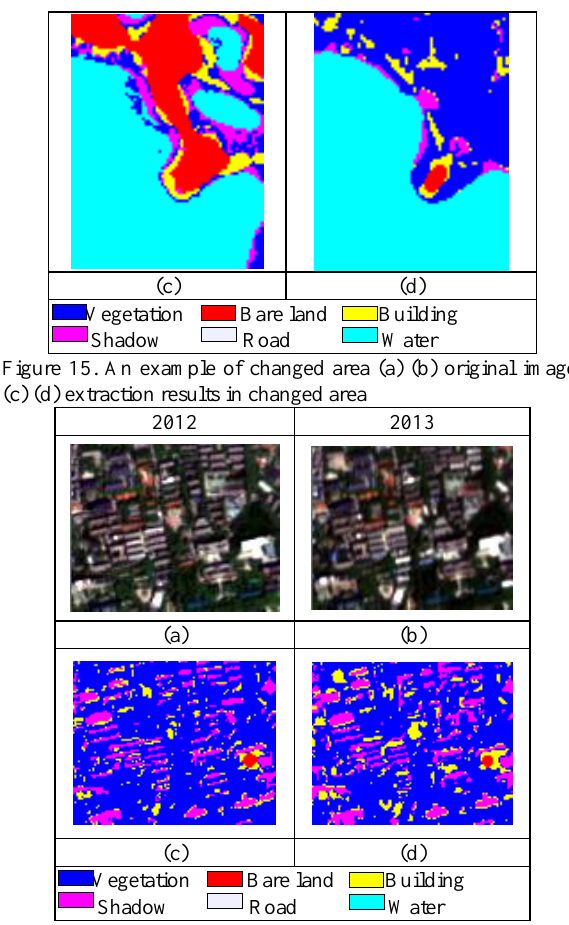
Figure 16. An example of unchanged area (a) (b) original image; (c) (d) extraction results in unchanged area